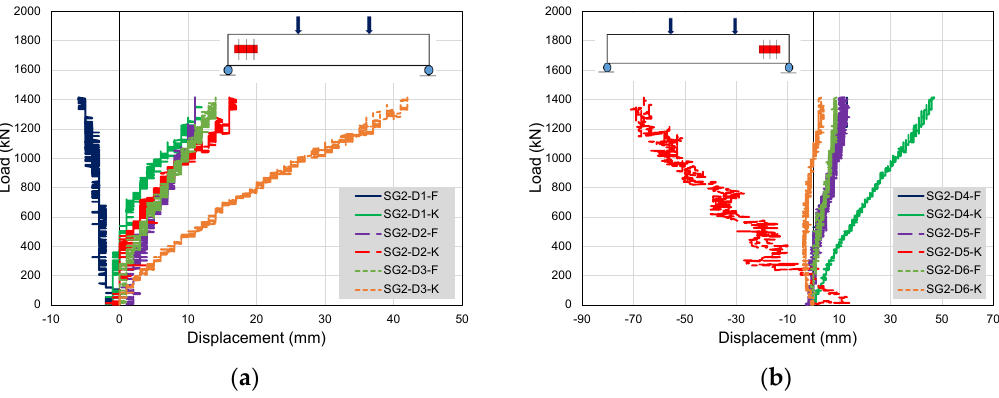
Figure 29. Load versus strain responses in load setup SP-2-L02 ( a ) D1–D3, and ( b ) D5–D6.